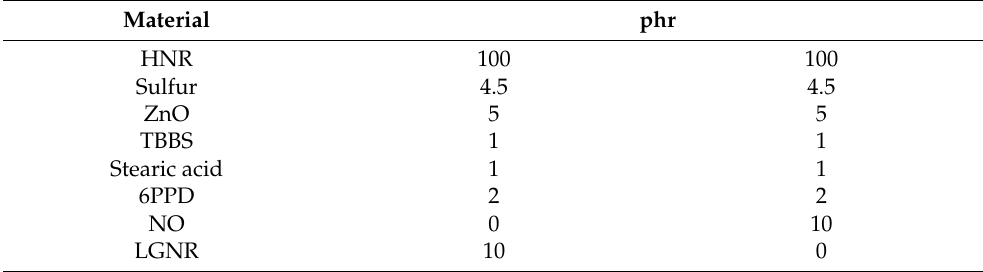
Table 2. Unfilled rubber compound